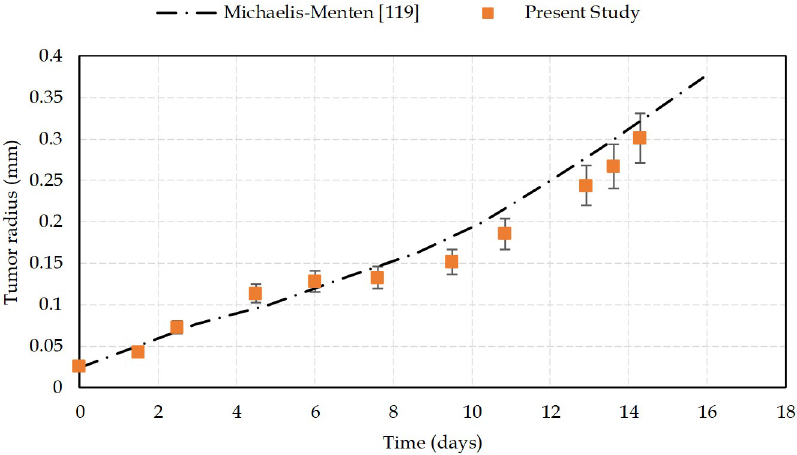
Fig 5. Tumor radius changes over time. A comparison between numerical results from the Taghibakhshi et al. [119] model, based on Michaelis-Menten reaction of oxygen consumption, and the current study. Initial radius of the tumor is 24.3 μ m. Error bars represent standard deviations of the mean of 5